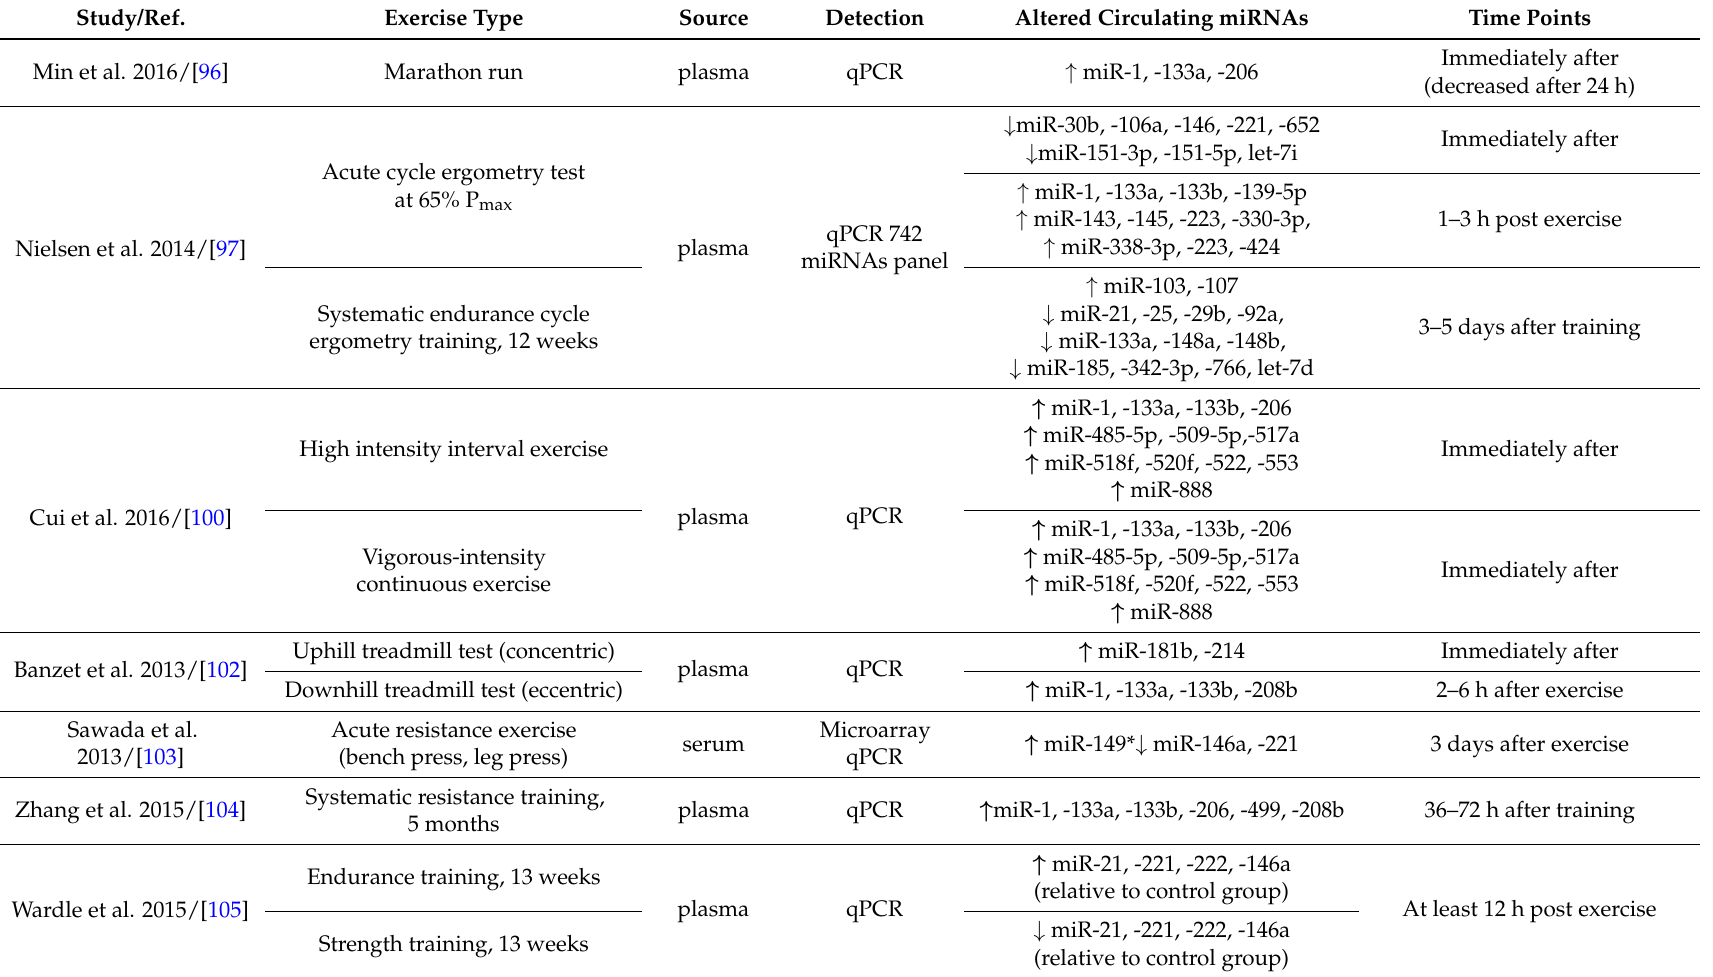
Table legend: ↑ —upregulated miRNAs; ↓ —downregulated